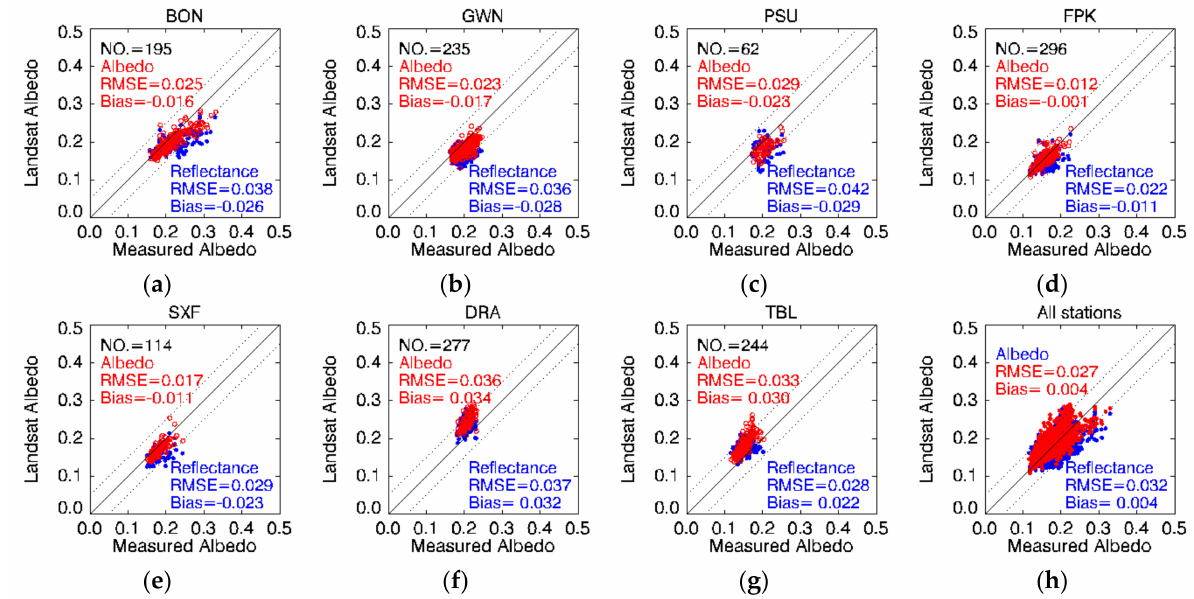
Figure 11. Comparison of Landsat shortwave albedo and reflectance with ground measurements at seven SURFRAD sites from 2000 to 2010: ( a – g ) the station of BON, GWN, PSN, FPK, SXF, DRA, and TBL, respectively; ( h ) result of all